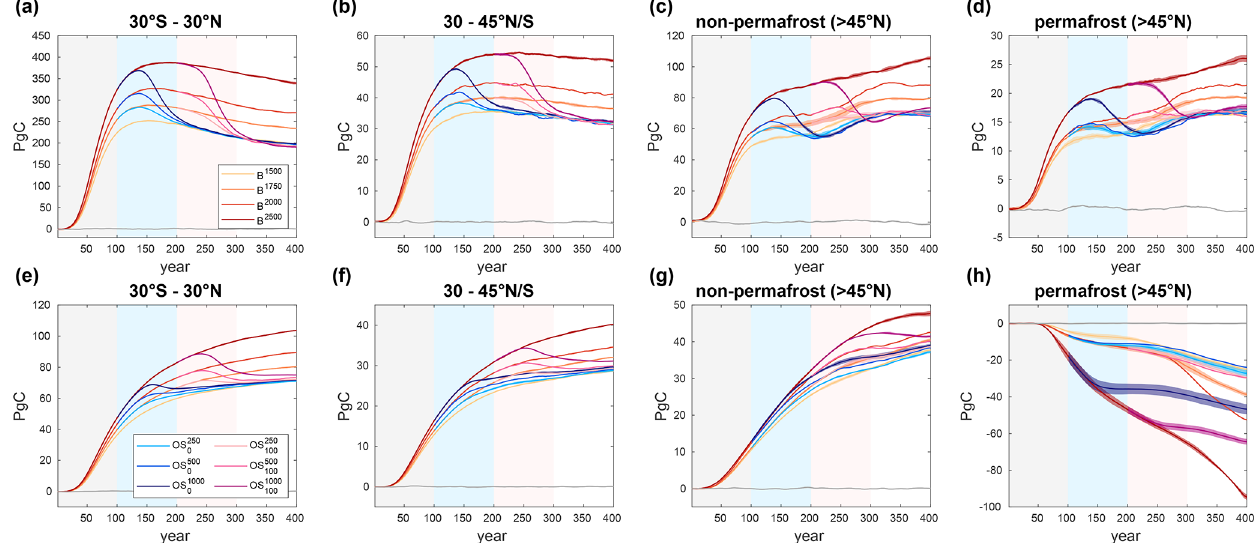
Figure 6. Tropical (a) , low-latitude (30–45 ◦ N, b ), high-latitude ( > 45 ◦ N) non-permafrost (c) , and high-latitude permafrost (d) vegetation carbon. Panels (e) – (h) show corresponding plots for soil carbon. The shaded areas in the background indicate the different phases of the simulations (grey: positive emissions; light blue: negative emissions for the short overshoots; light red: negative emissions for the long overshoots).